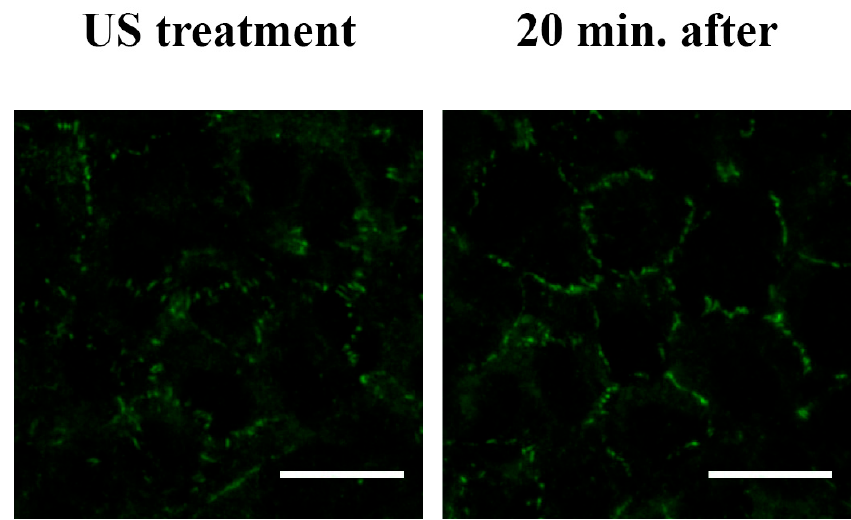
Figure 8. Restoration of the ZO-1 subcellular localization in the absence of US stimulation. The RBE4 cells were treated for 20 min with US, and the distribution of ZO-1 was evaluated 20 min after the removal of the treatment. The ZO-1 distribution clearly shows an unaltered localization, with no significant differences in comparison to the control (untreated cells) (Figure 7). Five microscopic fields per treatment have been recorded. Total magnification 400×; scale bar: 25 µm. This result was also confirmed by the cytological staining analysis (Figure 9), where the intercellular gaps induced by US stimulation were significantly reduced 20 min after US removal.